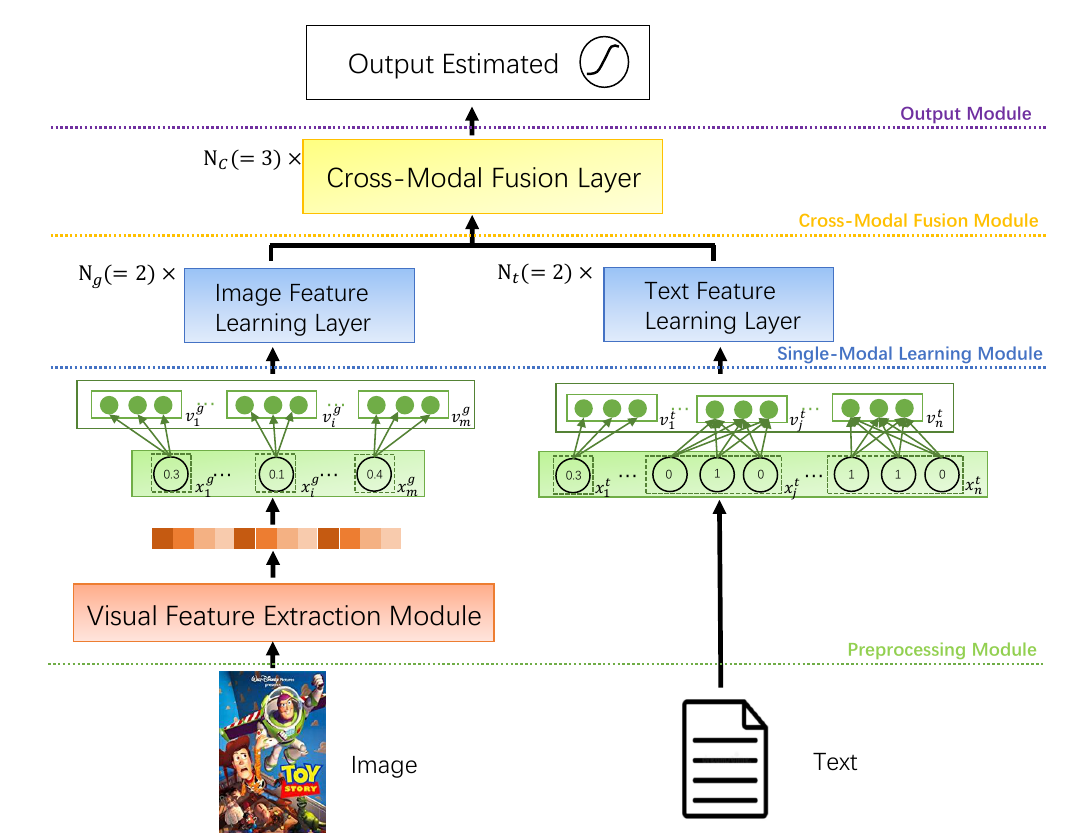
Figure 1. Overview of the proposed framework based on CMBF. The details of the Image/Text Feature Learning Layer and the Cross-modal Fusion Layer are illustrated in Figures 2 and 3,